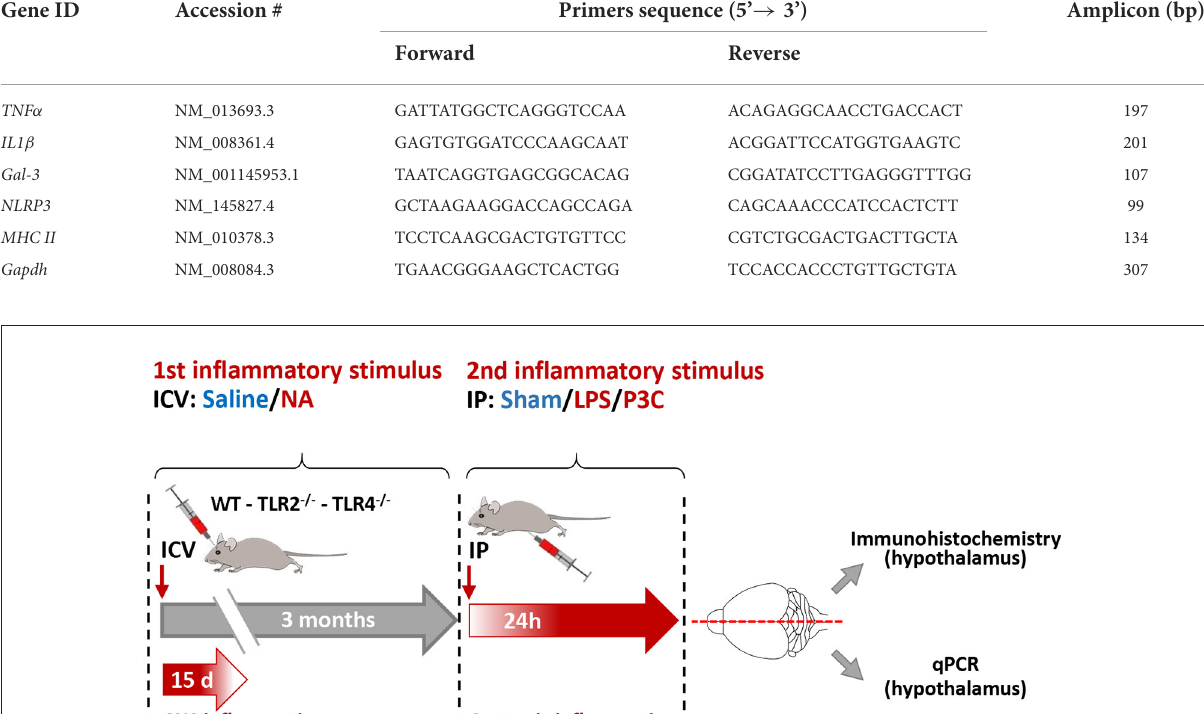
TABLE 1 Sequences of the primers used for qPCR.